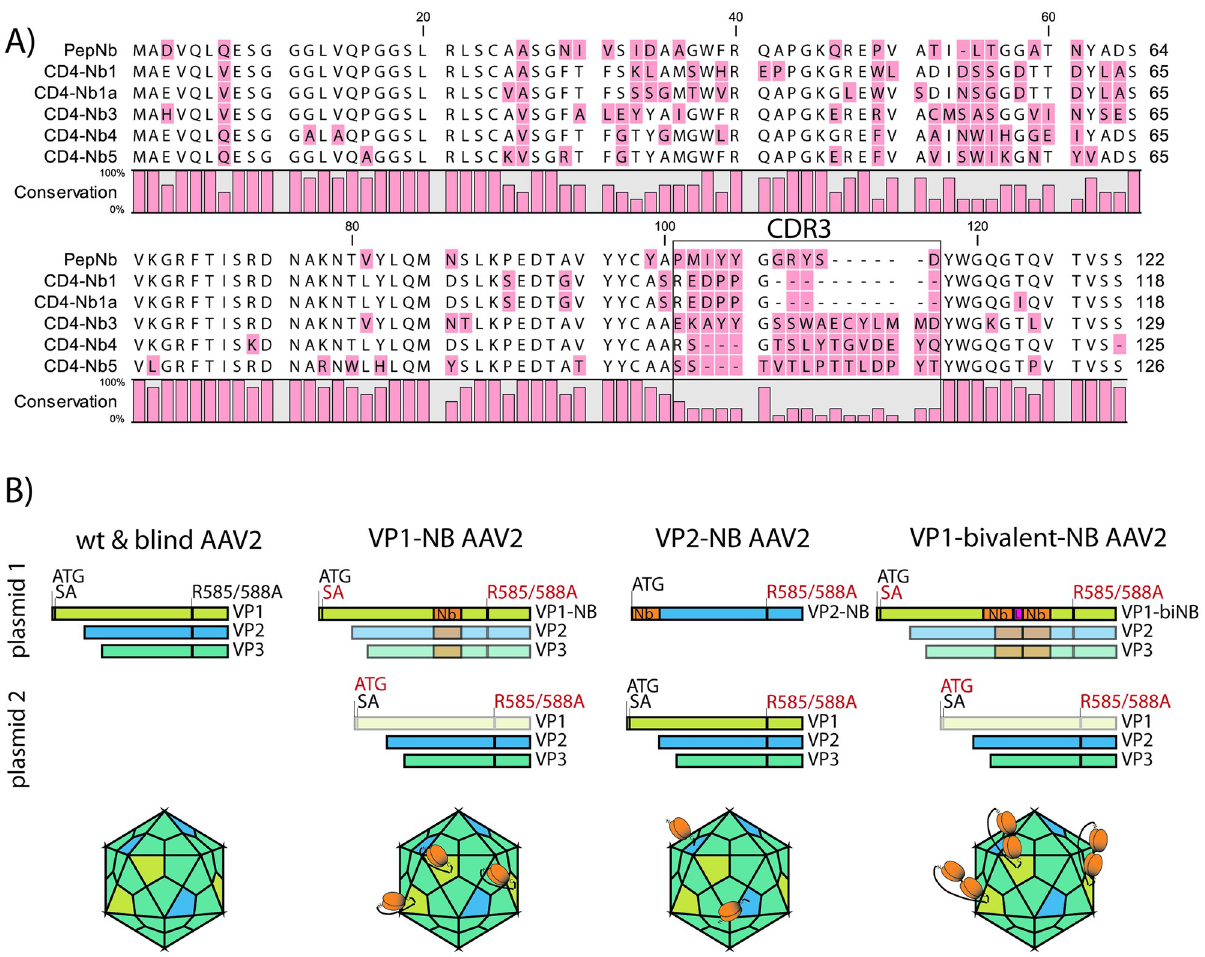
Fig 1. Nanobody (Nb) sequences and AAV2-Nb design. (A) Amino acid alignment of the Nb sequences used in this study. Nb annotation is in accordance with the study by Traenkle and coworkers [39], which describes thorough Nb characterization and application for in vivo imaging. Of note, CD4-Nb1a is not specified in Traenkle et al., as its complementary determining region 3 (CDR3, black box) is identical to CD4-Nb1 (amino acids 101– 117 in the alignment). (B) Plasmid constructs used for production of indicated AAV2 particles and schematic representation of the resulting capsids. Equimolar amounts of plasmids were co-transfected into HEK293T cells (see Methods). For clarity, adenoviral helper plasmid and vector encoding the eGFP reporter included in all co-transfections are not depicted. Essential changes to optimized viral capsid proteins VP1-3 are indicated: red = mutated / black = wt. Disabled open reading frames are greyed out. ATG = start codon; SA = splice acceptor site; Nb = full length nanobody sequence as presented in A (orange); L = glycine-serine linker genetically fusing nanobody monomers in the bivalent constructs (pink); R585A/ R588A = Arg to Ala amino acid substitution at residues 585 and 588 (blind). AAV capsids were rendered with help of the browser tool by Antonio Negro´n [42].